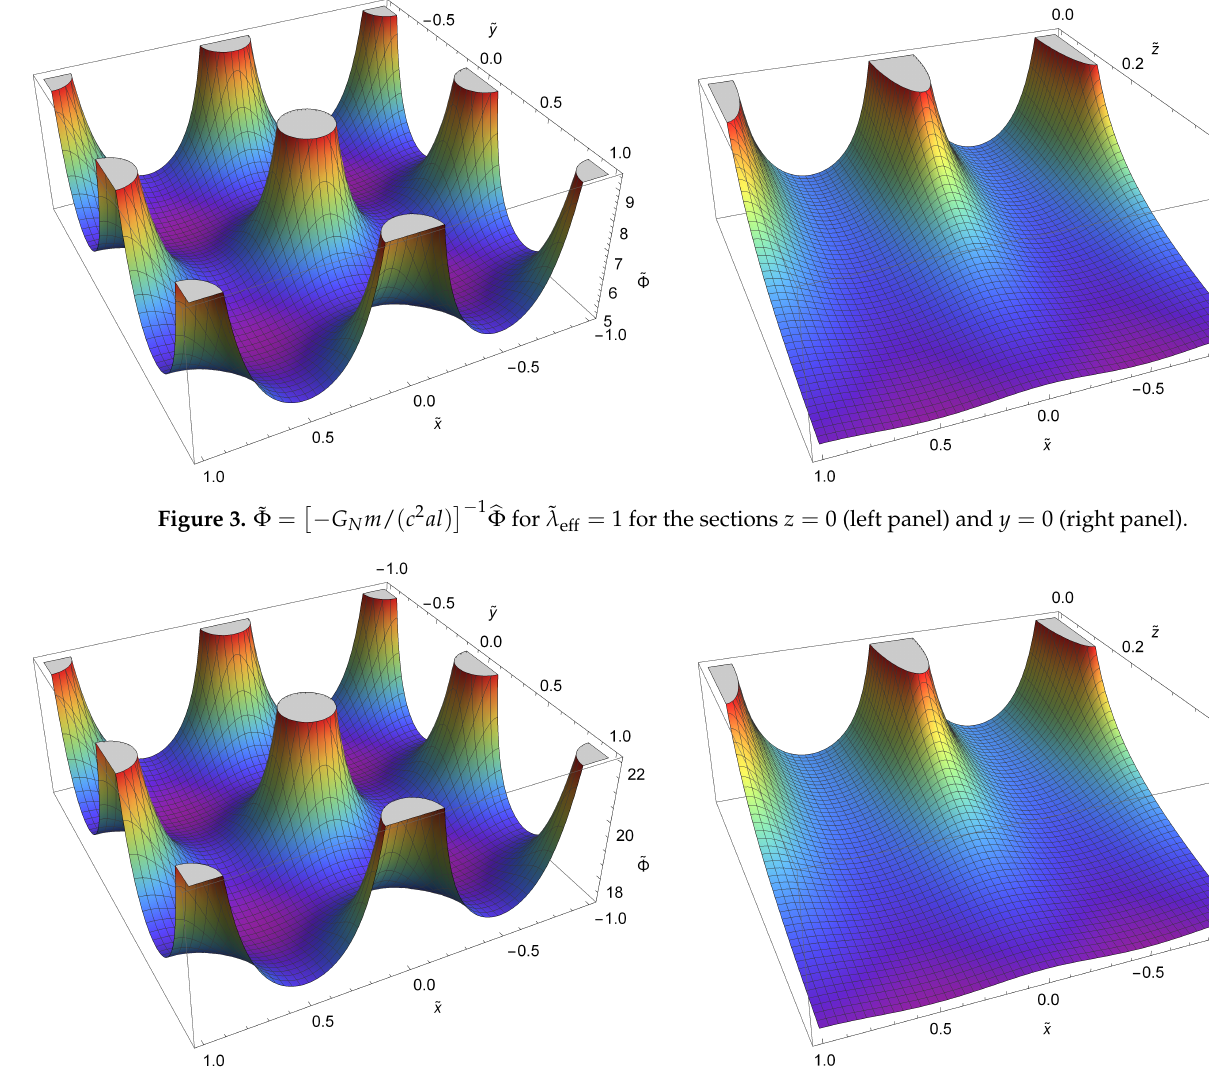
(cid:2) − (cid:3) − 1 G N m / ( c 2 al ) Figure 4. ˜ Φ = (cid:98) Φ for ˜ λ eff = 3 for the sections z = 0 (left panel) and y = 0 (right